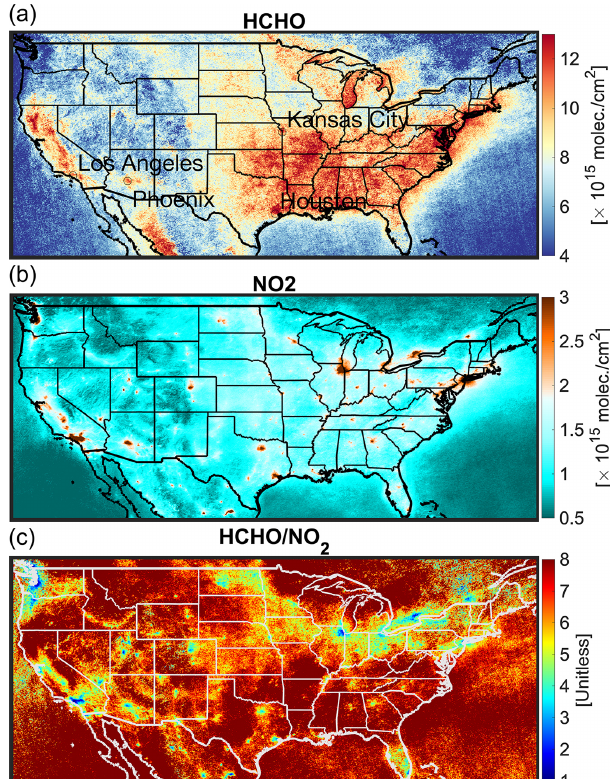
Figure 7. Oversampled TROPOMI total HCHO columns (a) , tro- pospheric NO 2 columns (b) , and the ratio (c) at 3 × 3km 2 from June till August 2021 over the US. The ratio map is derived from the averaged maps shown in panels (a) and (b)